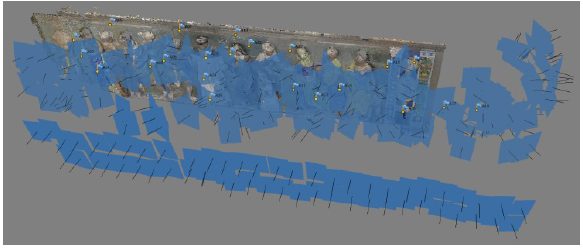
Figure 3. Test area camera network